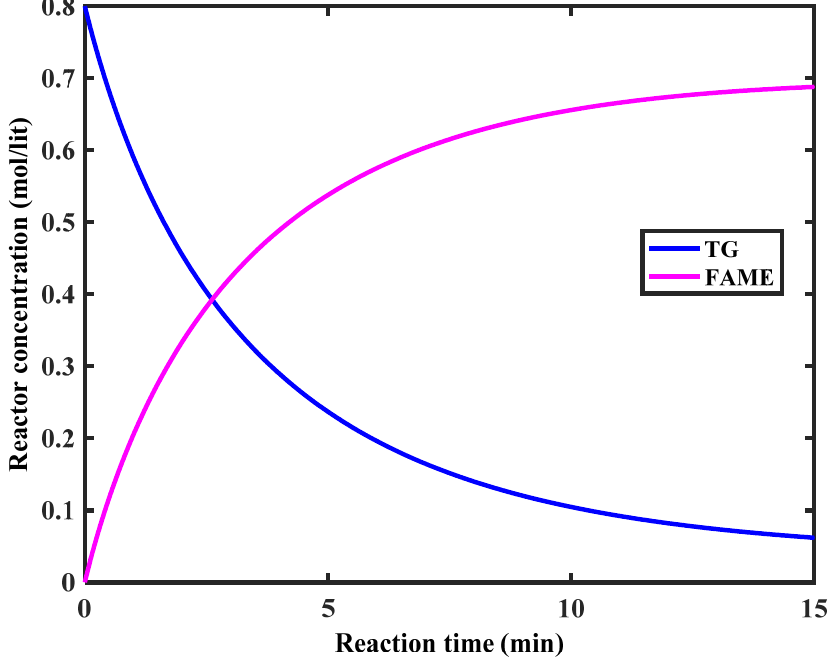
Figure 11. TG and FAME concentrations at reactor outlet, T = 68 °C, reactor volume = 80 lit.